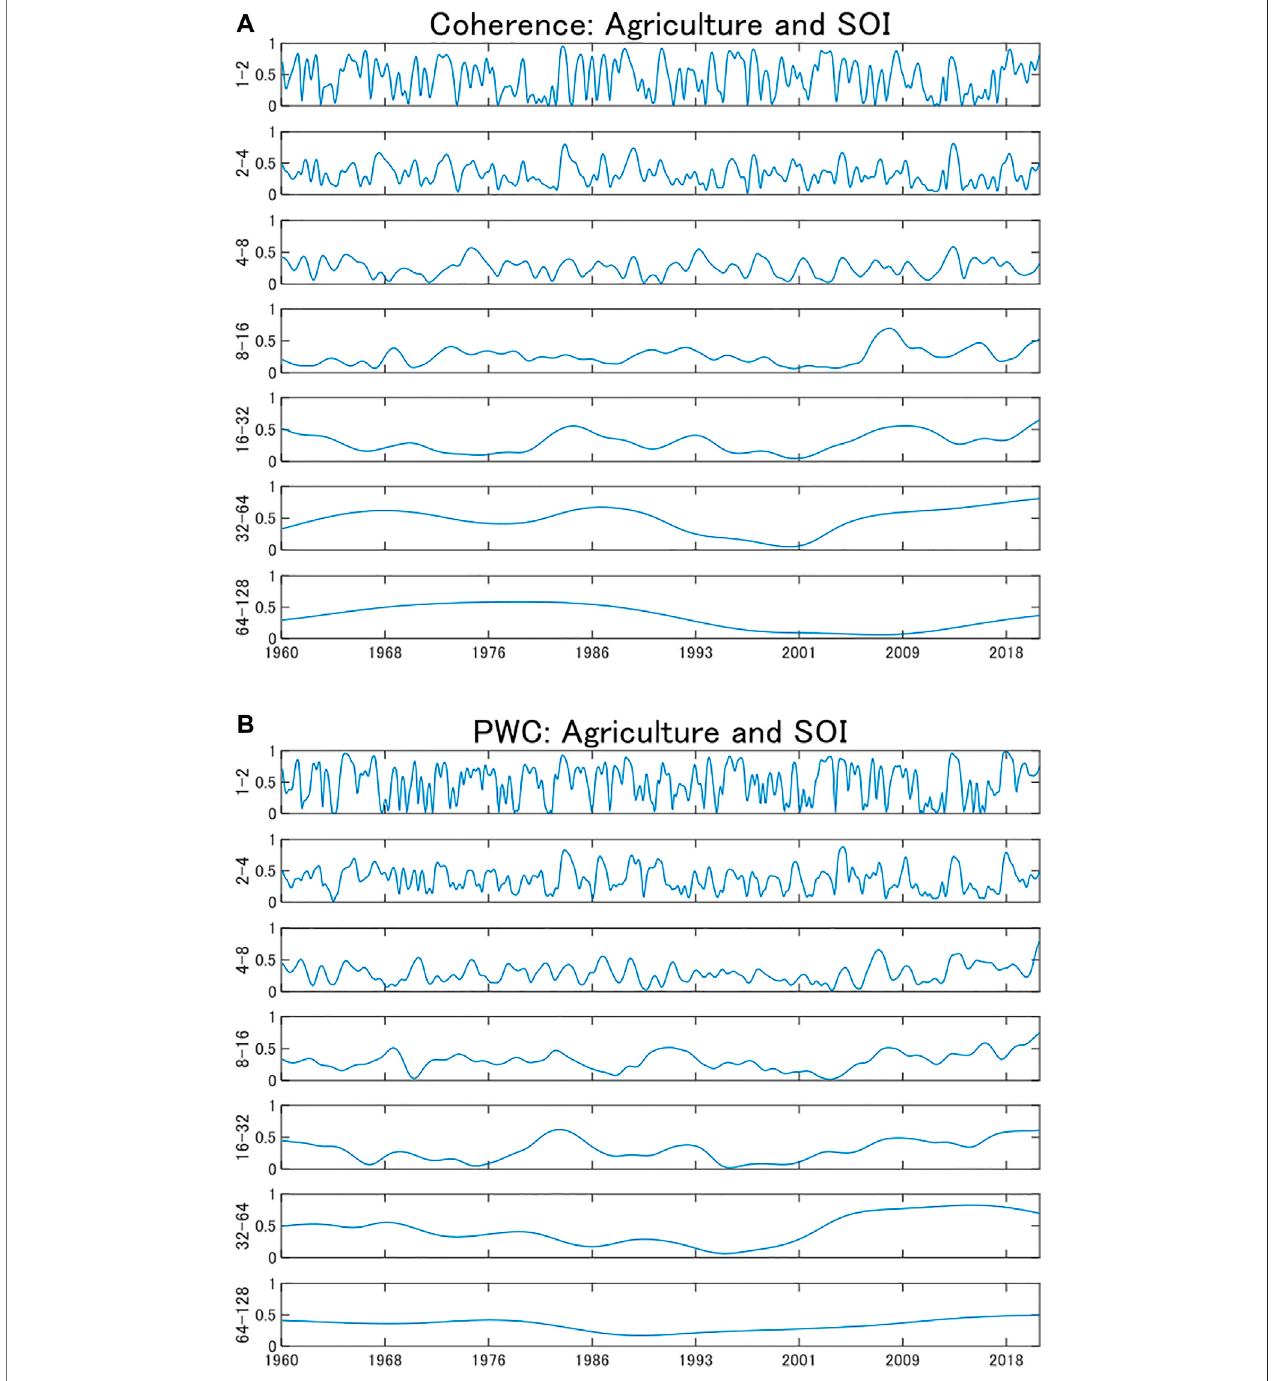
FIGURE 5 | Time-varying wavelet coherences (A) and partial wavelet coherences (B) between agriculture and SOI across different frequencies.